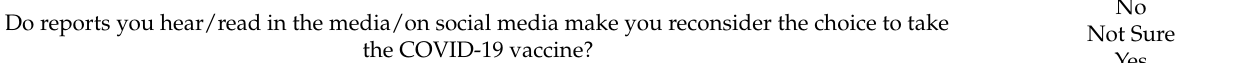
Table 1. The drivers of dental students’ COVID-19 vaccine hesitancy, February 2021 ( n = 6639). Item Outcome Contextual